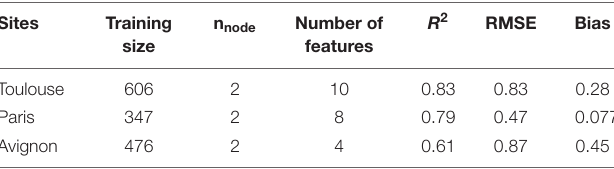
TABLE 3 | Performance of the estimation of the number of plants per object over three experiments. Sites